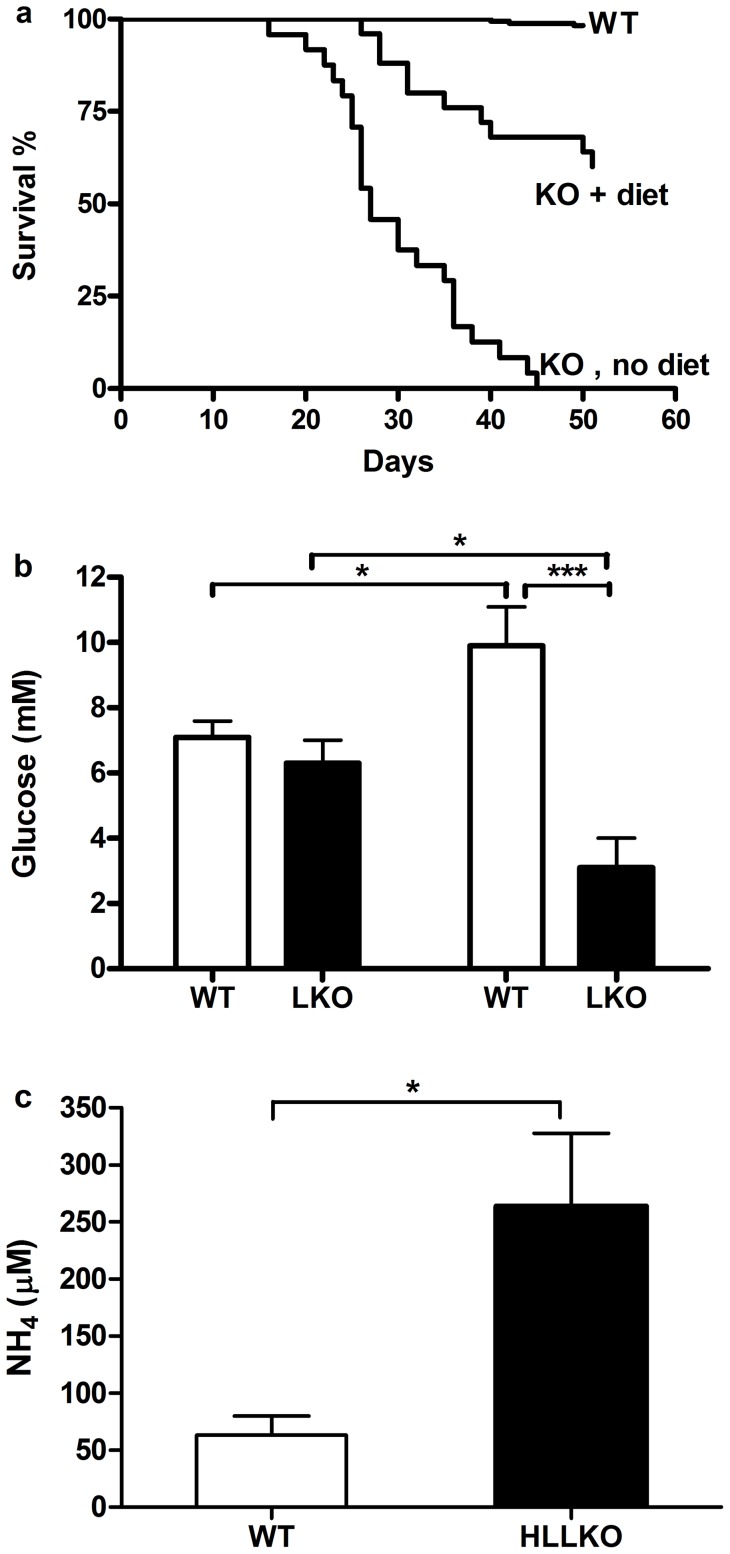
Fatal hypoglycemic, hyperammonemic coma in HLLKO mice.(a) Survival curves of the HLLKO mice with and without the modified diet are compared to a control group. HLLKO without diet, n = 24; HLLKO with diet, n = 25; controls, n = 25. (b and c) KIC injection causes hypoglycemic, hyperammonemic episodes in HLLKO mice. Mice received an injection of KIC, 2 mg/g and were tested at the onset of crises, which occurred 1–4 hours later. Mice were paired with for age- and sex-matched controls and were 3-8 months old. (b) Blood glucose levels of HLLKO and control mice before and during crises, n = 7. (c) Blood NH4 levels of HLLKO and control mice during crises., n = 5. Unfilled bars, controls; filled, HLLKO.